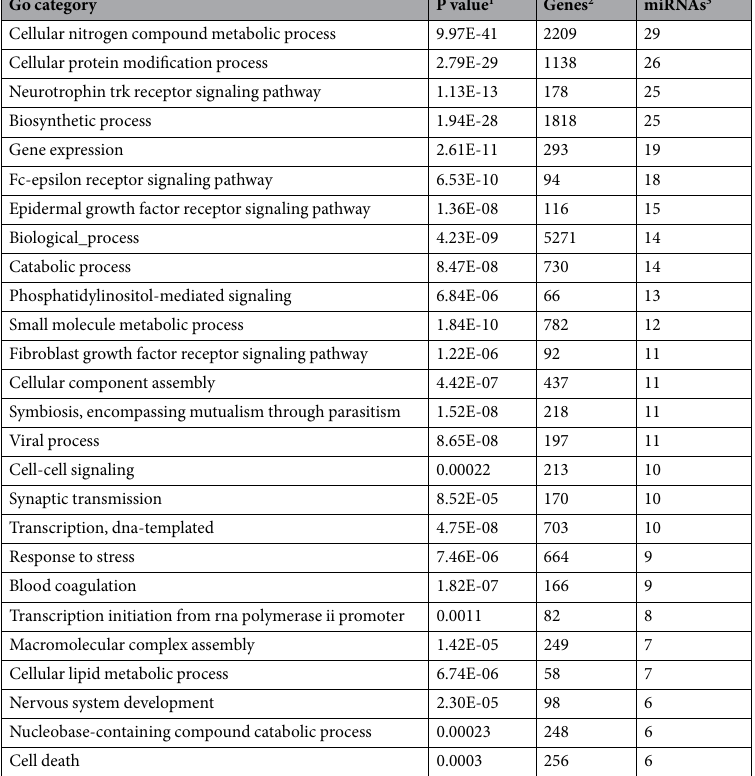
Table 3. Top 20 Gene Ontology Terms for biological processes of target genes from the 48 miRNAs differentially expressed in healthy and cancerous tissue of HNSCC patients. 1 Only GO Terms with P values lower than 0.05 were considered as significant. 2 Number of genes affected in the process by the regulated miRNAs. 3 Number of miRNAs differentially expressed that have a target gene in the